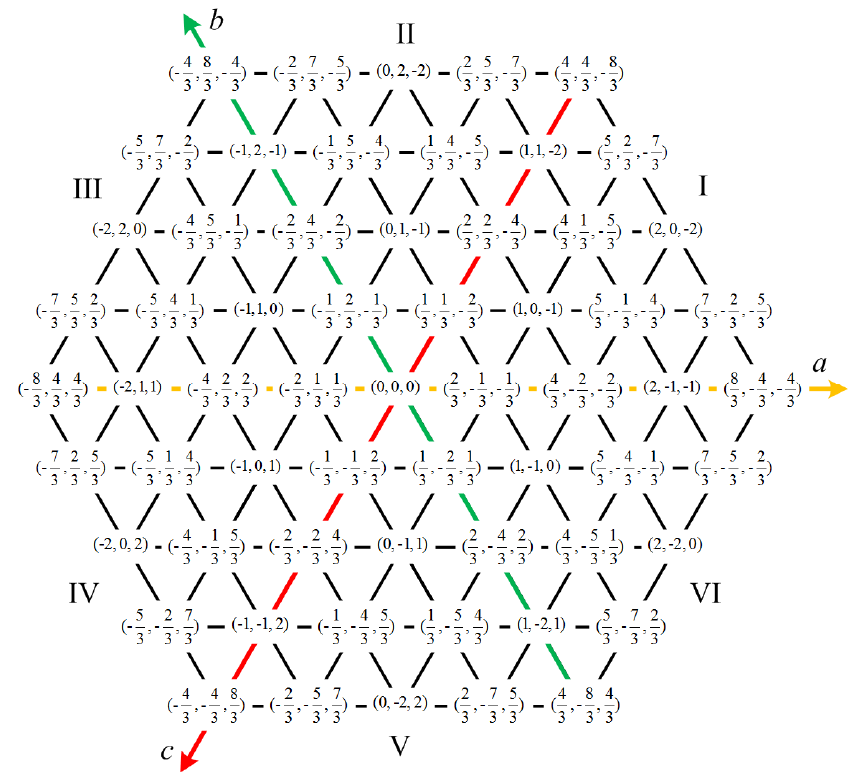
Figure 3. The coordinate components of the voltage space vectors in the a-b-c coordinate system.